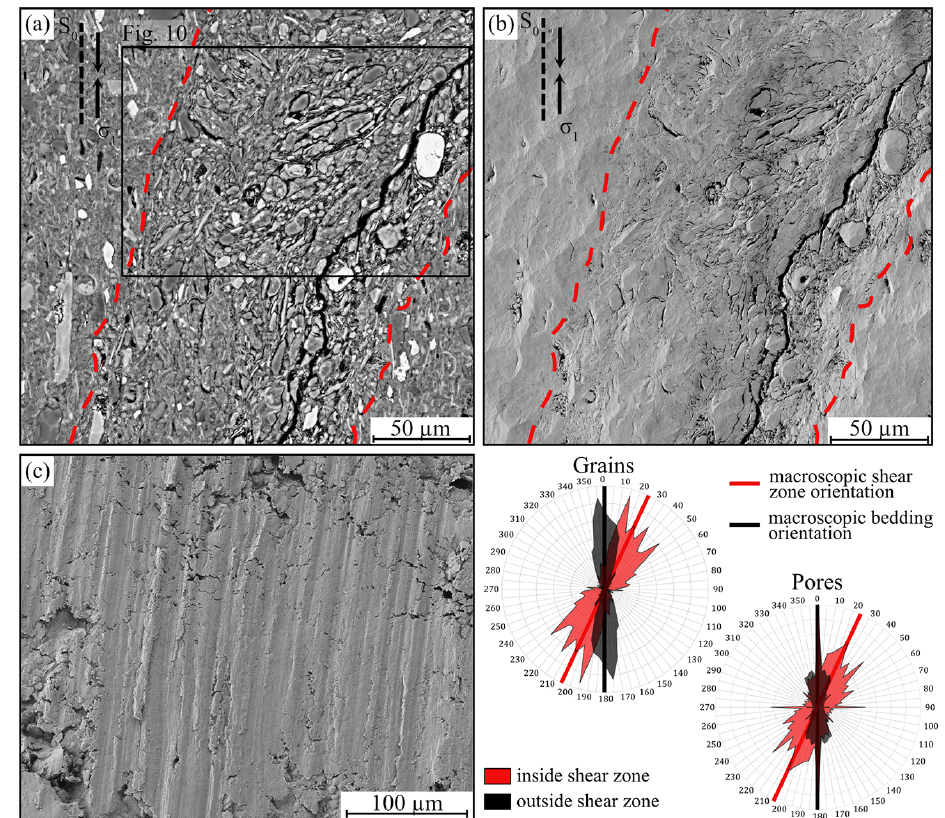
Figure 9. SEM images of the sample deformed at 4MPa effective confinement presenting the shear zone as well as orientations of grains, pores, and macroscopic structures. Panel (a) shows grain orientation (BSE image), (b) shows the increased apparent porosity in the shear zone, and (c) displays the surface morphology of a shear plane (both SE2 images). Rose diagrams of grains and pore within and outside of the shear zones indicate the self-similarity of structure orientations across different scale